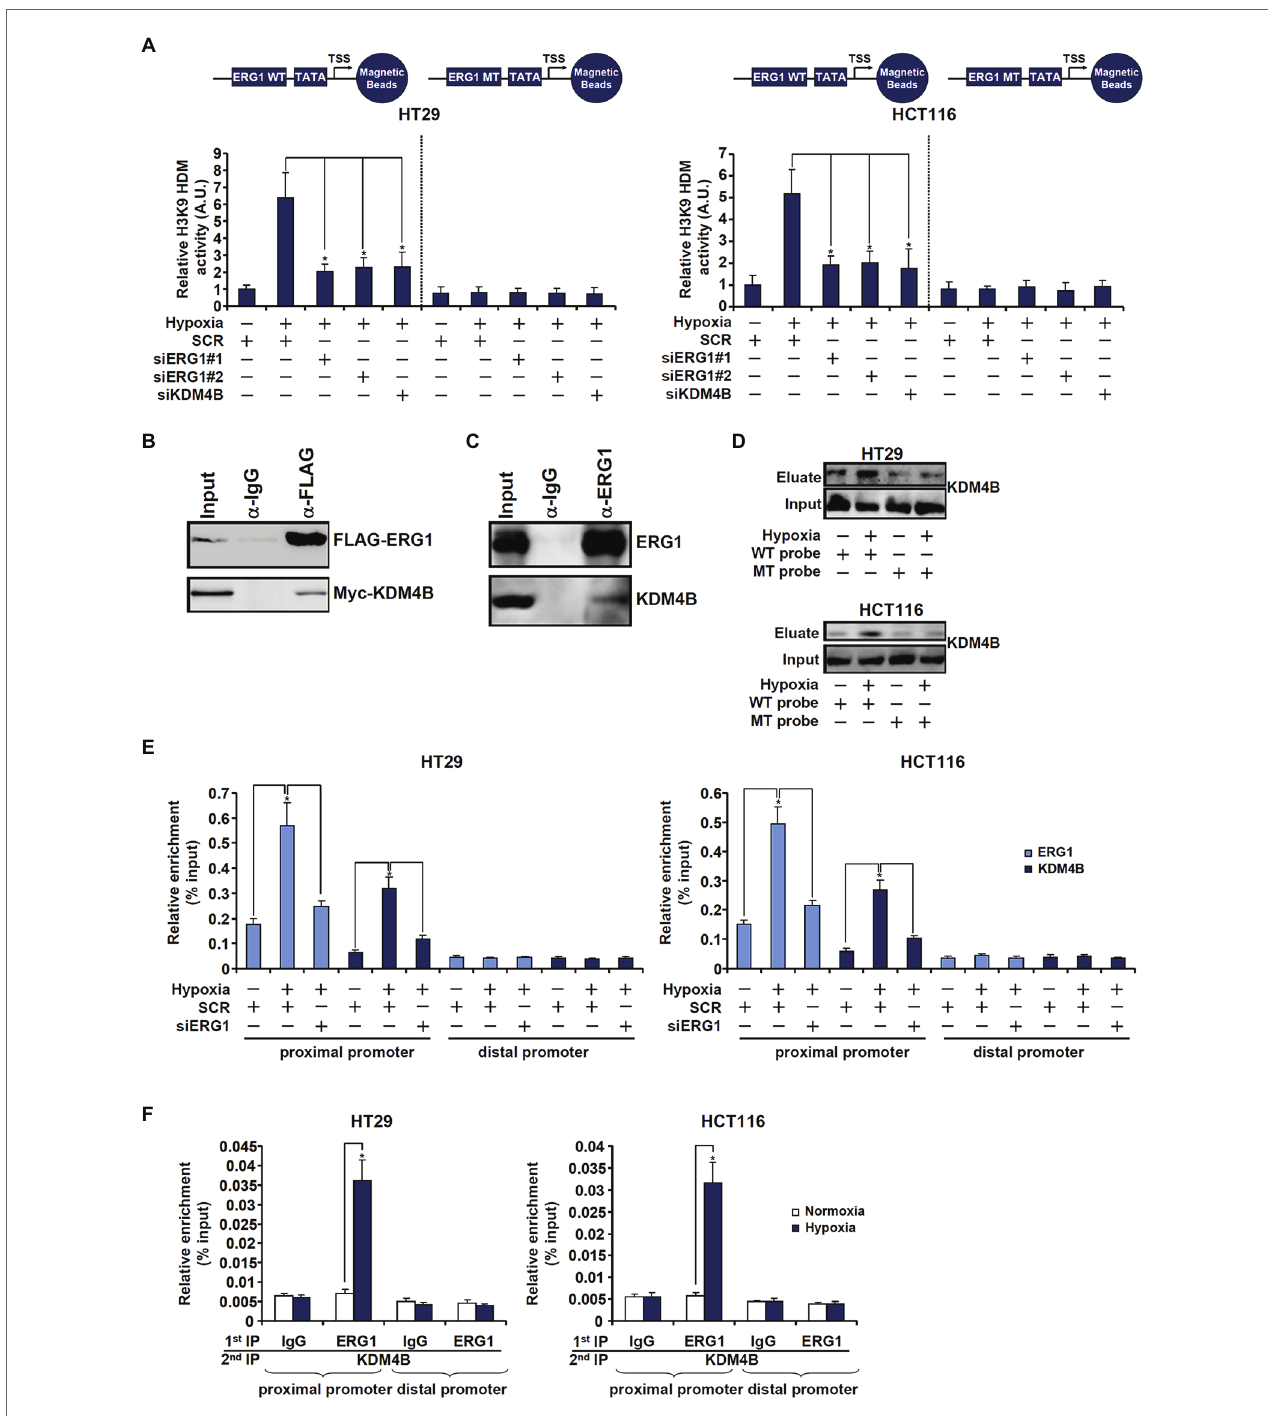
FIGURE 3 | ETS-related gene 1 (ERG1) recruits KDM4B to the TCL promoter. (A) HT29 and HCT116 cells were transfected with indicated siRNAs followed by exposure to hypoxia. Nuclear proteins were extracted and incubated with the WT or the MT TCL probe. In vitro HDM assay was performed as described in the section “Materials and Methods.” (B) HEK293 cells were transfected with indicated expression constructs. Immunoprecipitation was performed with anti-FLAG or IgG. (C) HT29 cells were exposed to hypoxia for 24 h. Nuclear lysates were extracted and immunoprecipitation was performed with anti-ERG1 or IgG. (D) HT29 and HCT116 cells were transfected with indicated siRNAs followed by exposure to hypoxia. Nuclear lysates were extracted and DNA affinity pull-down assay was performed as described in the section “Materials and Methods.” (E) HT29 and HCT116 cells were transfected with indicated siRNAs followed by exposure to hypoxia. ChIP assays were performed with anti-KDM4B or anti-ERG1. (F) HT29 and HCT116 cells were treated with or without hypoxia for 24 h. Re-ChIP assay was performed with indicated